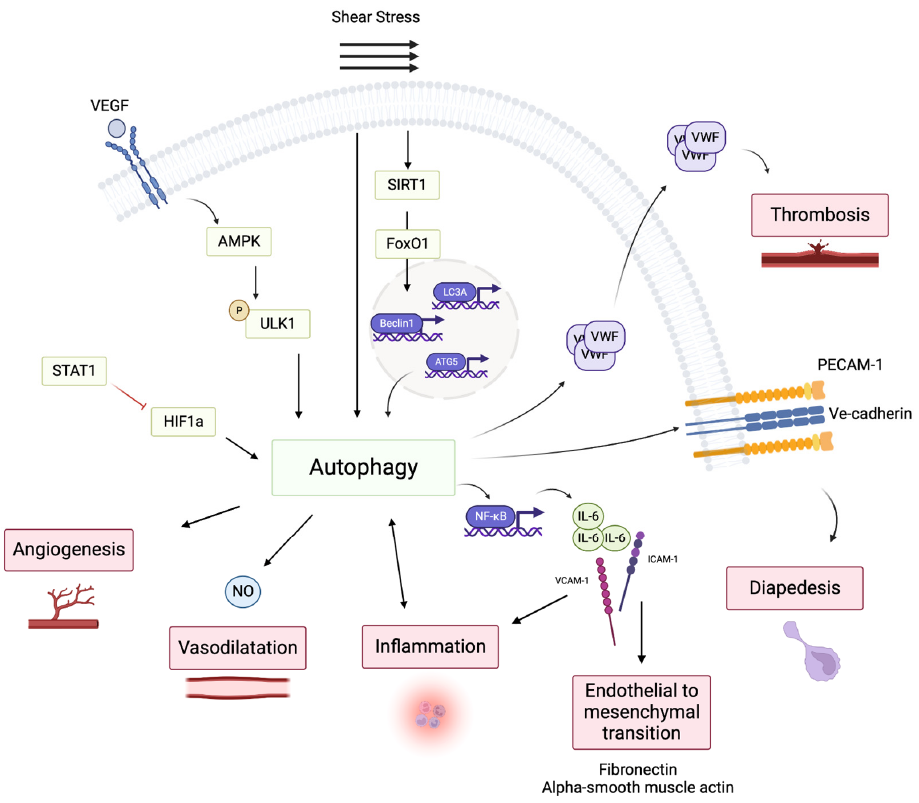
Figure 1. Main regulations of endothelial functions by autophagy. Extracellular signals such